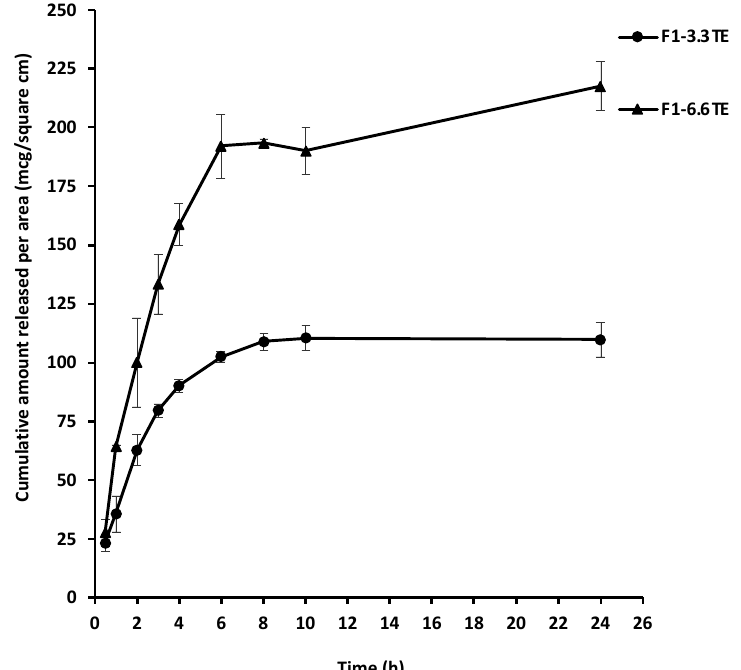
FIGURE 2 - In vitro release profiles of tartaric acid from tamarind fruit pulp extract loaded nanoemulsions across cellulose acetate membrane. Each point represents mean ± SD, n=3-4, where n is number of replications. TABLE VI - Release parameters of tamarind extract loaded nanoemulsions (mean ±SD, n=3-4, where n is number of replications) Zero Formulation